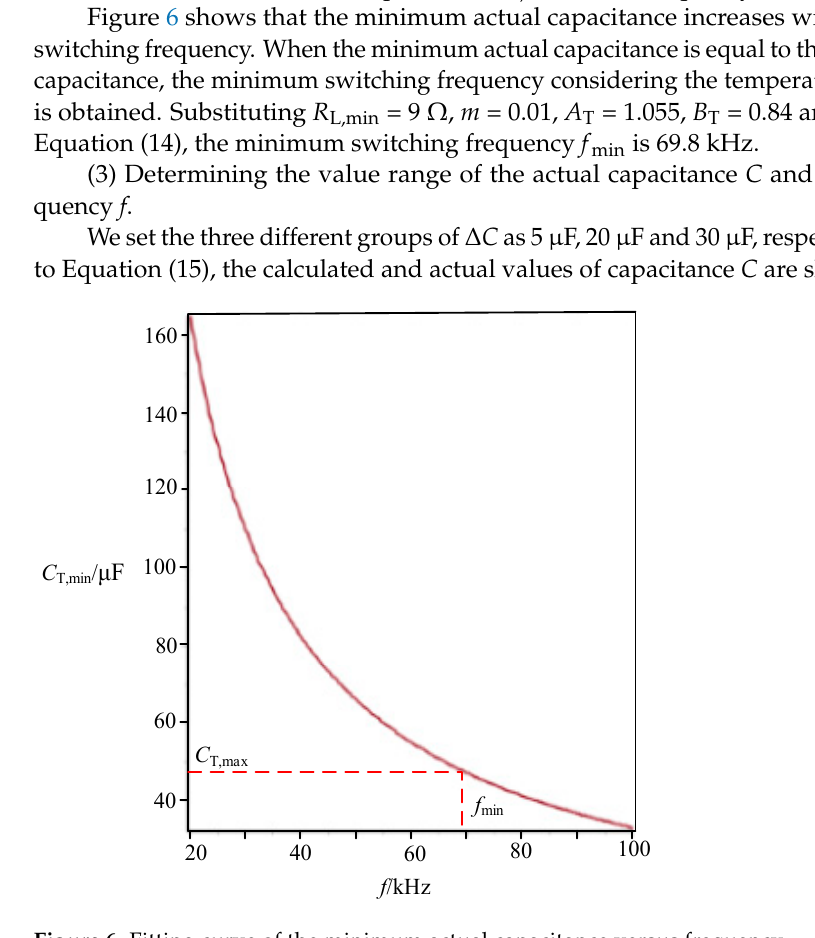
Figure 6. Fitting curve of the minimum actual capacitance versus frequency.